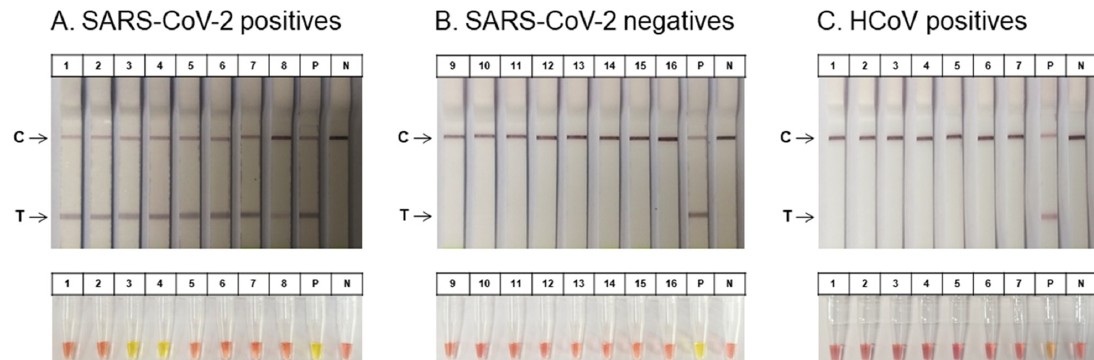
Figure 6. Clinical application of RT-LAMP and the DMP-PVDF filter system on human specimens. Clinical application of the RT-LAMP and DMP-PVDF filter system were analyzed for 23 human nasopharyngeal specimens with or without SARS-CoV-2 infection for the S gene of SARS-CoV-2 detection. ( A ) Eight patient specimens with SARS-CoV-2 infection were analyzed using the RT-LAMP and DMP-PVDF filter system by RT-LAMP with LFA (upper) and colorimetric RT-LAMP (lower). ( B ) Eight healthy participant specimens without SARS-CoV-2 infection were analyzed using the RT-LAMP with DMP-PVDF filter system by RT-LAMP with LFA (upper) and colorimetric RT-LAMP (lower). ( C ) Specificity of RT-LAMP assay for SARS-CoV-2 detection. ( C ) RT-LAMP assay was performed using 7 evaluated clinical nasopharyngeal specimens from 5 HCoV-OC43 ( lanes 1–5) and 2 HCoV-229E ( lanes 6 and 7) patients for the S gene of SARS-CoV-2. The RT-LAMP assays were performed at 65 °C. RT-LAMP with LFA (upper) and colorimetric RT-LAMP (lower). RT, reverse transcription; LAMP, loop-mediated isothermal amplification; S, spike; LFA, lateral flow assay; P, positive control; N; negative control; T, target; C, control.